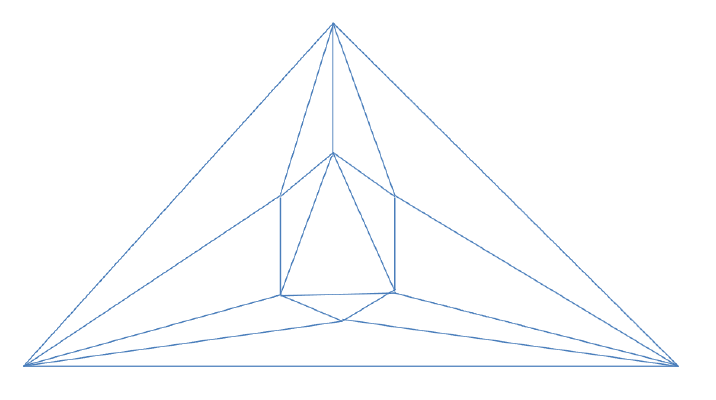
Figure 3. A triskaidecahedron that is not irreducible everywhere